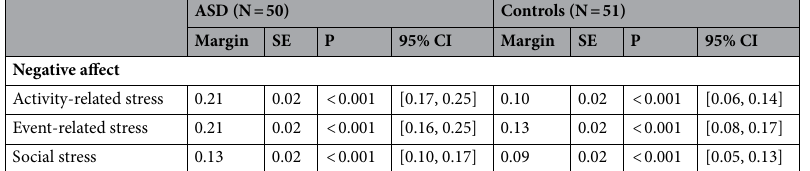
Table 3. Estimated marginal means of stress on negative affect in the ASD and control group. SE, standard error; 95% CI, 95% confidence interval; ASD, Autism Spectrum Disorder.